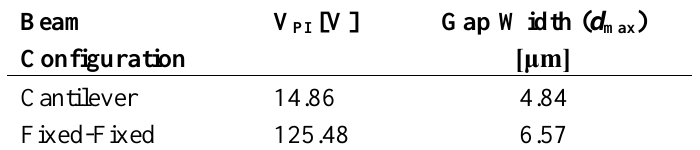
Table 5. Linearly varying gap case results (required 2 μm displacement).